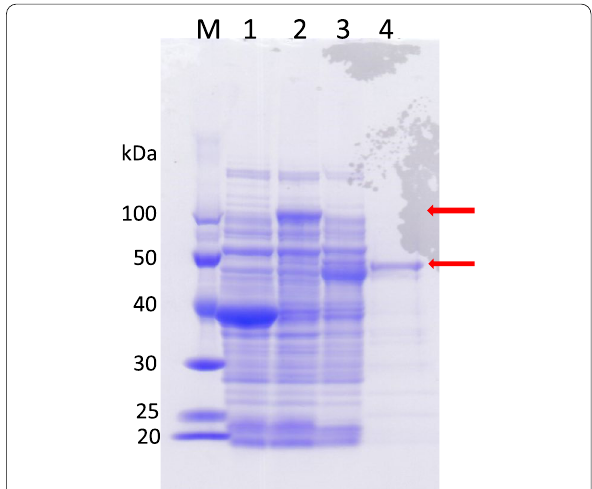
Fig. 2 SDS-PAGE analysis of recombinant MBP-Lcc120-3 (MBP-Mic-mg-MCO) and Lcc120-3 without MBP (Mic-mg-MCO), which were expressed in E. coli BL21 (DE3). Lane M, molecular weight standards (Pre-stained XL-Ladder; APRO Science, Tokushima, Japan); lanes 1, 2, and 3, crude enzyme solutions from recombinant E. coli (pMAL-c5x/pG-KJE8, pMAL-c5x-Mic-mg-MCO120-3/pG-KJE8, and pMAL-c5x-Mic-mg-MCO120-3ΔMBP/pG-KJE8, respectively); lane 4, purified